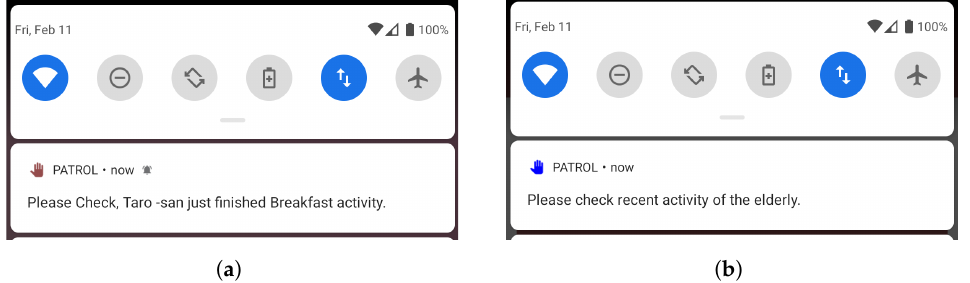
Figure 6. Example of notifications generated: ( a ) activity based notification (abN) and ( b ) recurring notification